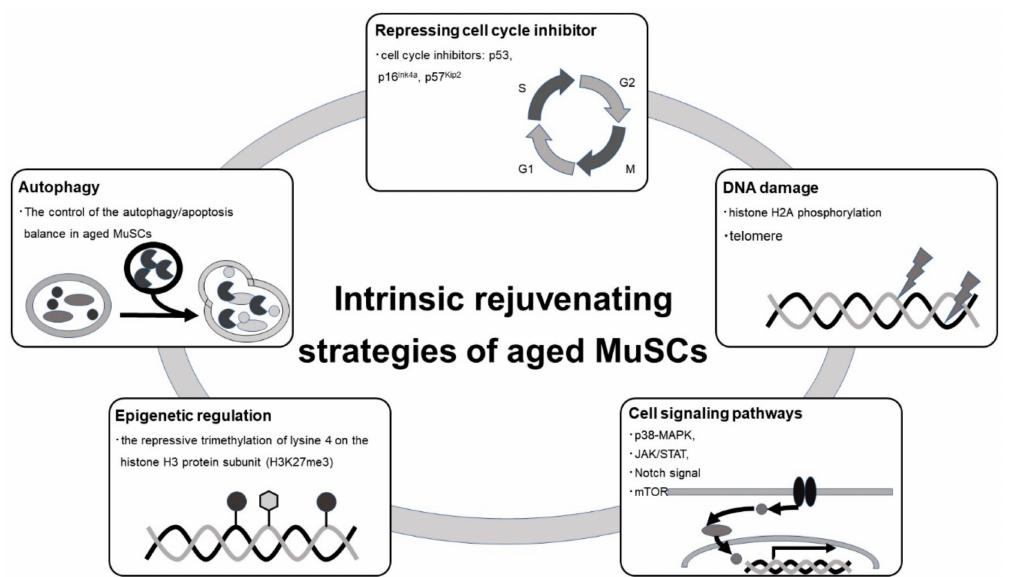
Figure 3. Intrinsic rejuvenating strategies of aged MuSC. MuSCs are controlled by intrinsic e ff ectors including cell cycle regulator, autophagy, epigenetic regulation, cell signaling pathways, and DNA damage. Aged MuSCs would regain the capacity for self-renewal, and proliferation and di ff erentiation by regulating these intrinsic e ff